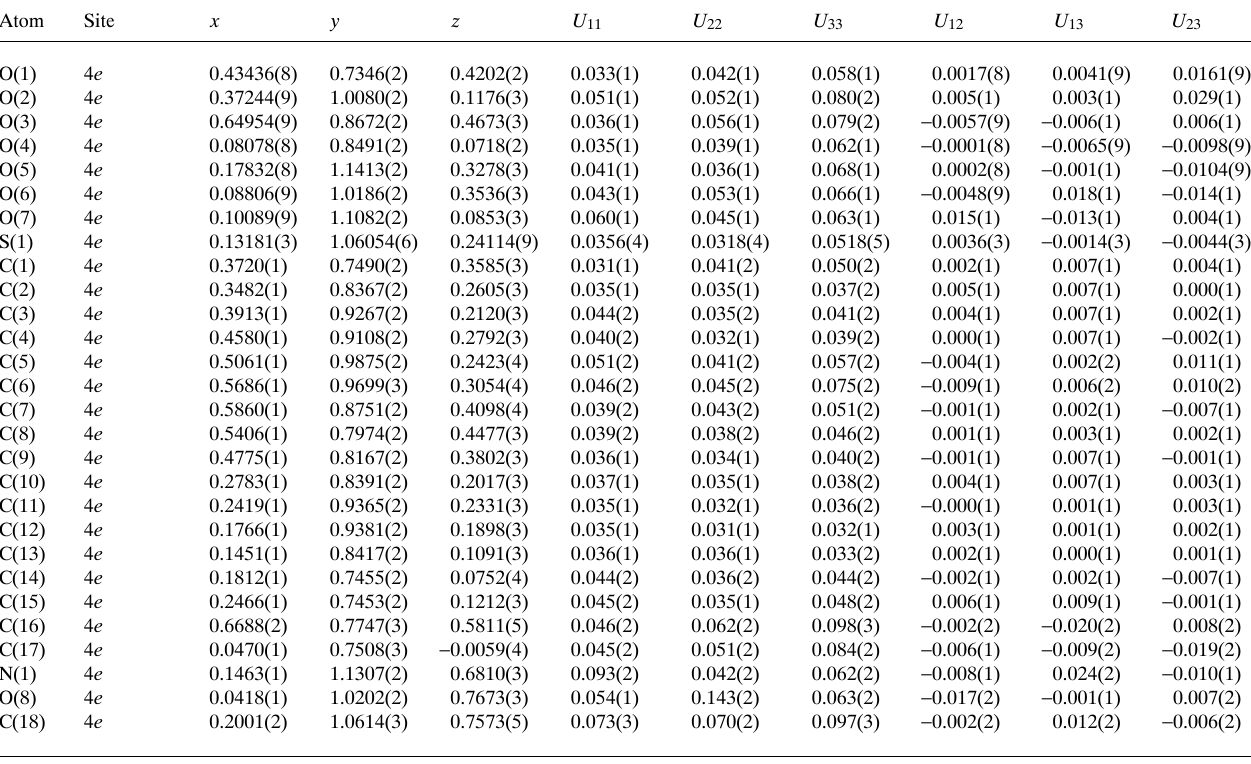
Table 3. A tomic coordin a tes a nd displ a cement p a r a meters (in Å 2 ) .